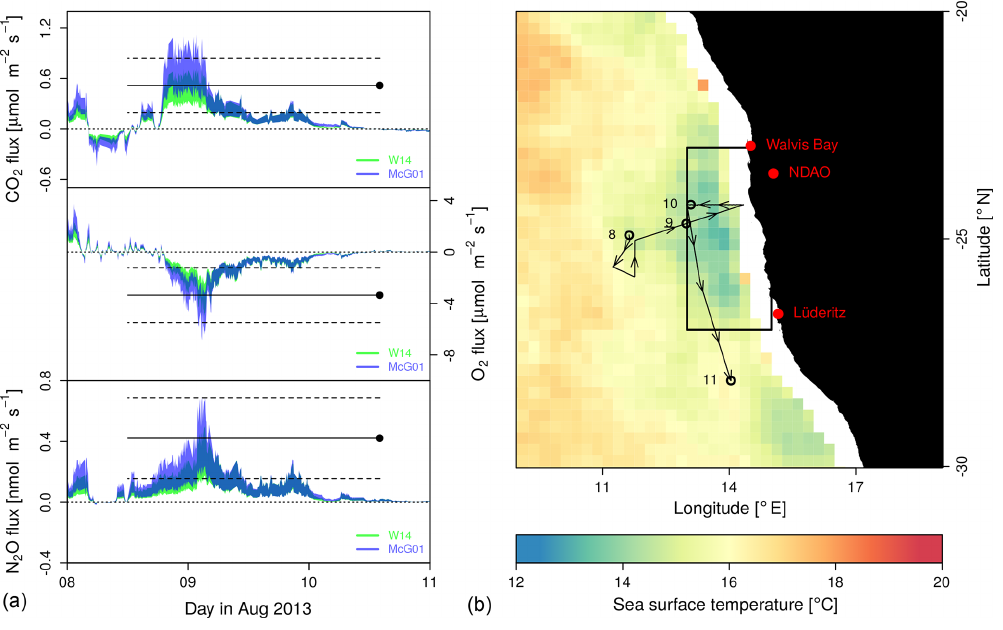
Figure 8. Air–sea flux densities for CO 2 , O 2 , and N 2 O using bottom-up methods (a) , with a shaded envelope depicting the estimated surface flux and its uncertainty. Two estimates are shown, each made with a different parameterization for k w . A positive value indicates net evasion. W14 and McG01 refer to the specific gas transfer velocity parameterization used. The top-down flux density estimate is plotted as a dot at the time of the peak of the associated atmospheric anomaly. The horizontal line extending from each dot represents the time period during which the flux density associated with the anomaly was estimated to have occurred. Dotted lines indicate the uncertainty of the top-down estimate. Grid-cell average TRMM SST data for the 3d period are overlain with a cruise track and the Lüderitz–Walvis Bay domain (b) . The days in August 2013 are marked with labels and open circles on the cruise